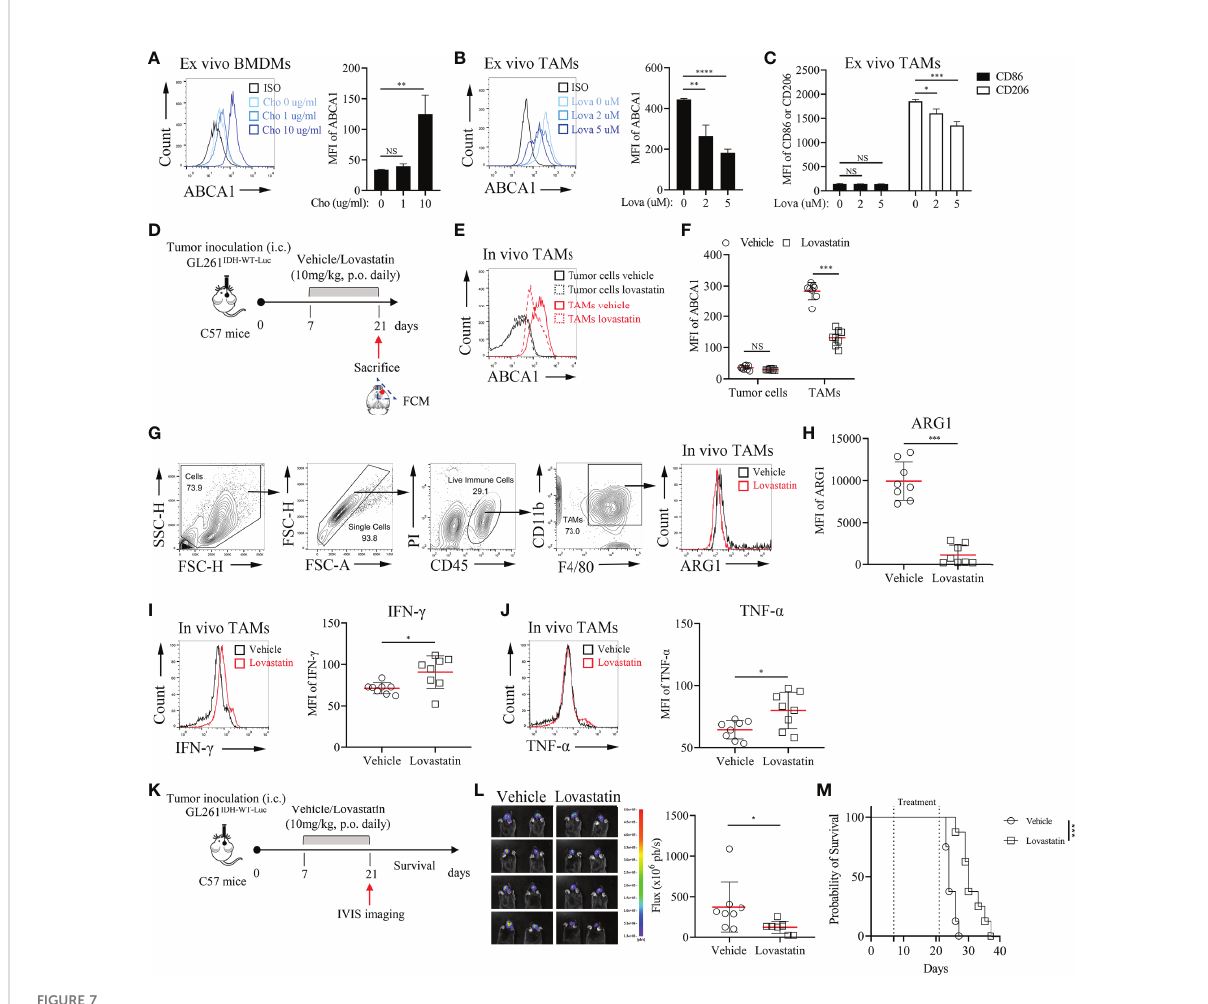
FIGURE 7 Pharmacological Inhibition of ABCA1 Enhances the In fl ammatory Polarization of TAMs In Vivo. (A) : Quanti fi cation of ABCA1 expression in cholesterol-treated BMDMs ex vivo. BMDMs were treated with the indicated concentrations of cholesterol for 24 h. Cells were harvested and FCM was performed to identify the expression level of ABCA1 (n = 3). (B, C) : Quanti fi cation of ABCA1 expression (B) and CD86 and CD206 expression (C) in lovastatin-treated TAMs ex vivo. TAMs were treated with the indicated concentrations of lovastatin for 24 h. FCM was performed to identify these molecular expressions. (D) : Experimental setup of lovastatin-treated murine IDH WT GBM model. Eight mice per group. (E, F) : Representative fl ow cytometry plots (E) and quanti fi cation of ABCA1 expression levels in TAMs (F) . (G – J) : Representative fl ow cytometry plots (G) and quanti fi cation of TAM functional polarization (H – J) . ARG1 (H) were identi fi ed as anti-in fl ammatory macrophage markers; IFN- g (I) and TNF- a (J) were identi fi ed as in fl ammatory macrophage markers. (K – M) : Experimental setup (K) and tumor growth